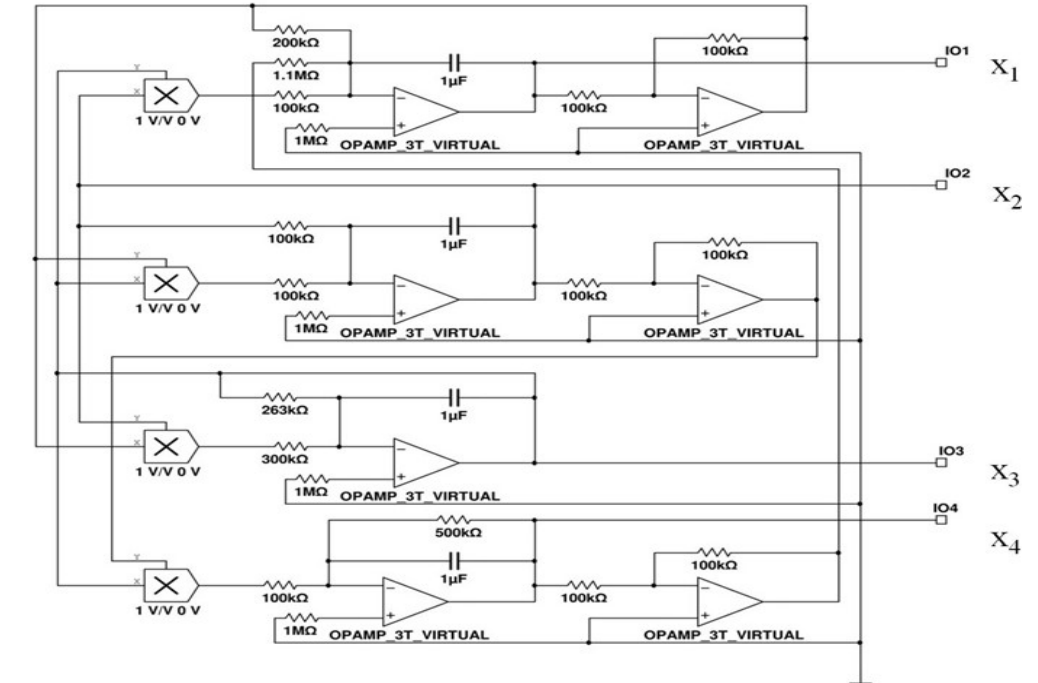
Figure 9. Circuit configuration of the master system